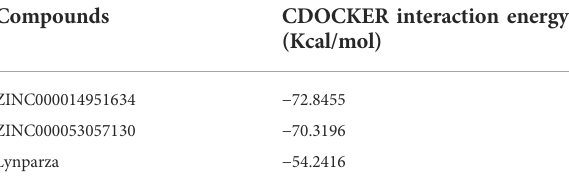
TABLE 4 | CDOCKER interaction energy of compounds with